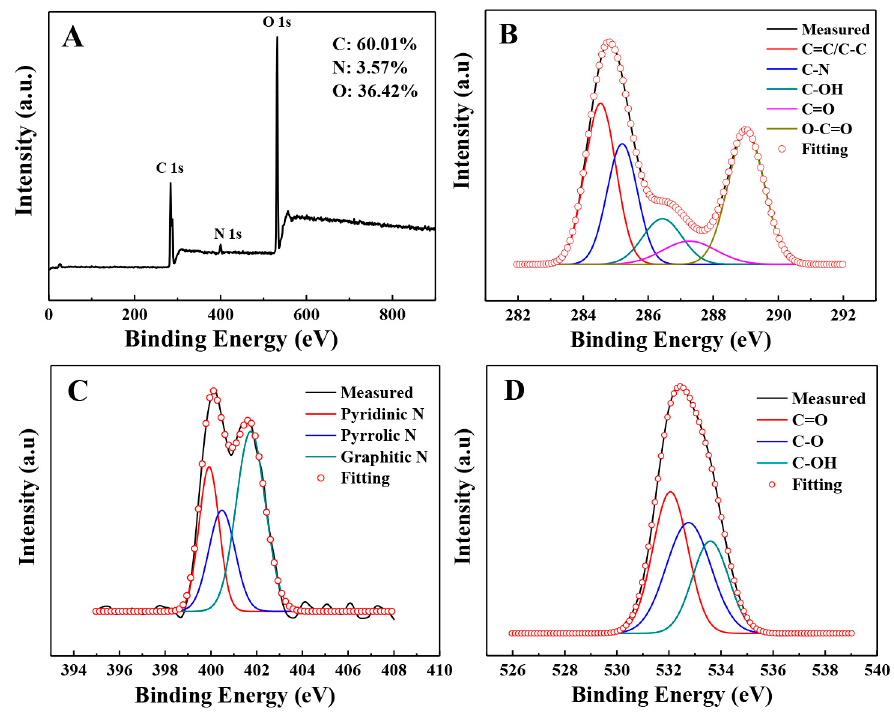
Figure 3. ( A ) Full scan XPS spectrum of the N-GQDs, and high solution XPS spectra of ( B ) C1s, ( C ) N1s, and ( D )